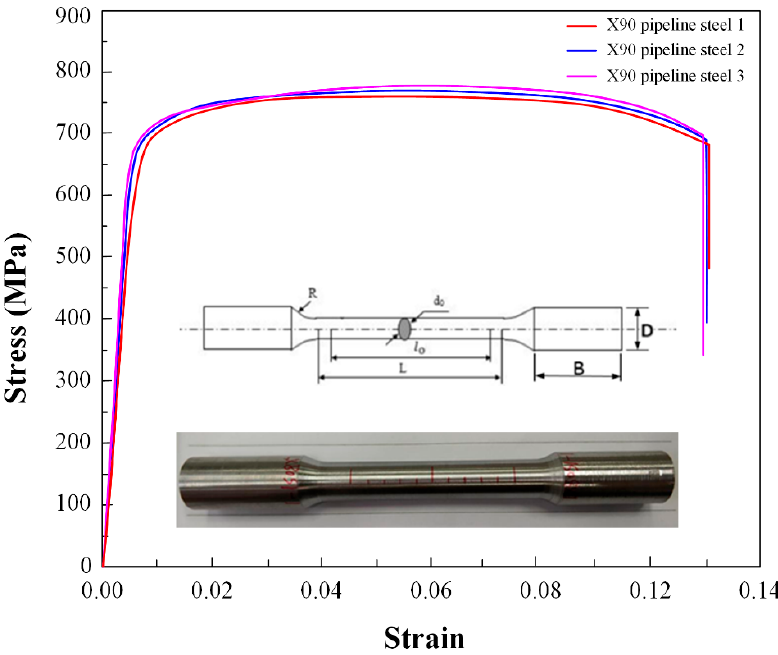
Figure 1. Engineering stress vs. engineering strain response obtained by uniaxial tensile test of X90 pipeline steel at room temperature. Table 2. Mechanical properties of X90 pipeline steel.